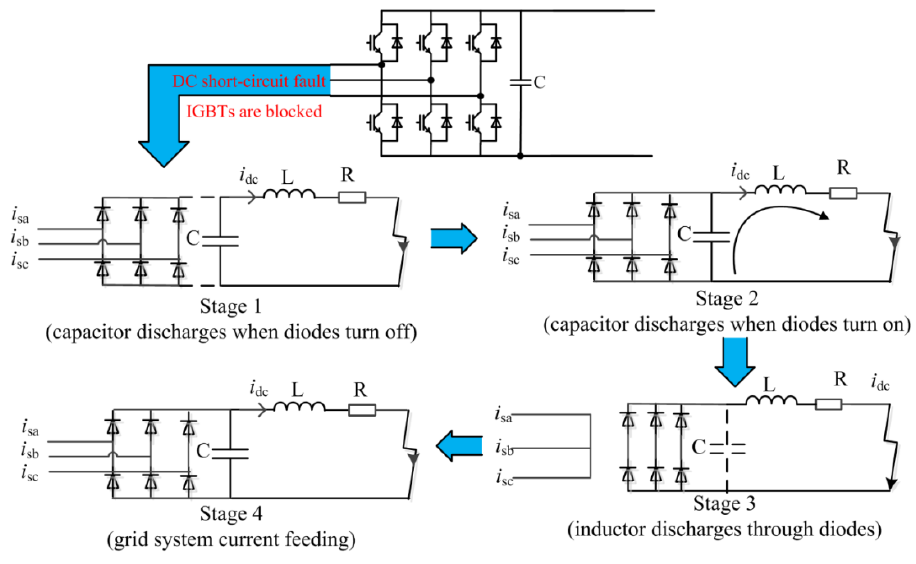
Figure 3. The four stages for the rectifier during a DC short-circuit fault without the SFCL.